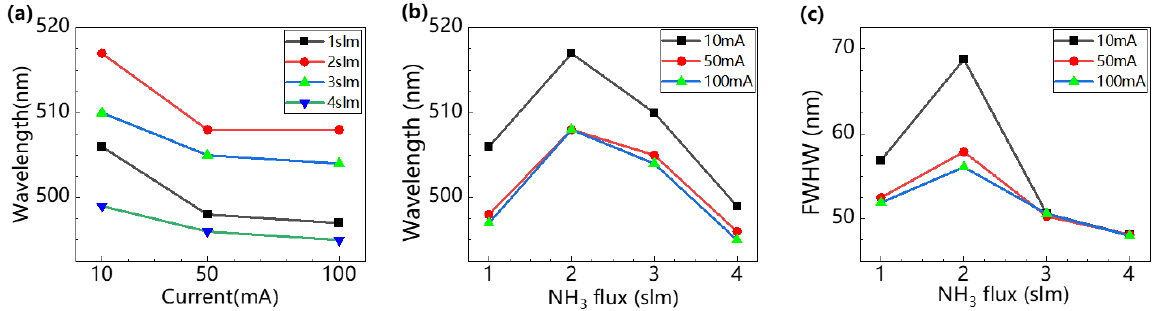
Figure 2. EL peak wavelength vs. injection current and NH 3 flux ( a , b ); FWHM ( c ) dependence on varying NH 3 flux measured under different injections of 10, 50 and 100 mA. The lines are connected for visual purposes.